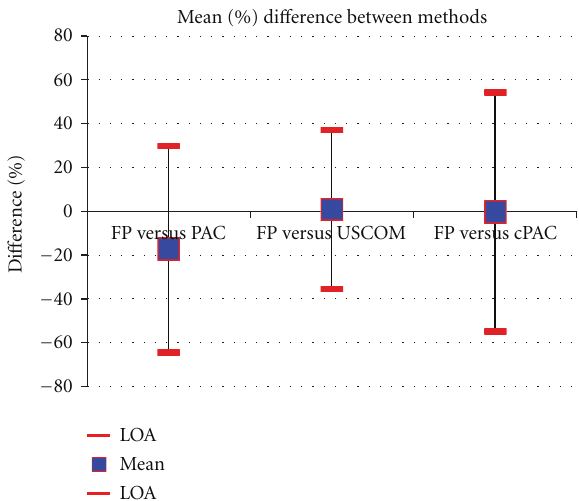
Figure 1: Percentage bias and precision for all paired measures for FP versus PAC ( − 17.2% and 47%), FP versus USCOM (1% and 36.4%), and FP versus cPAC ( − 0.2% and 54.4%).